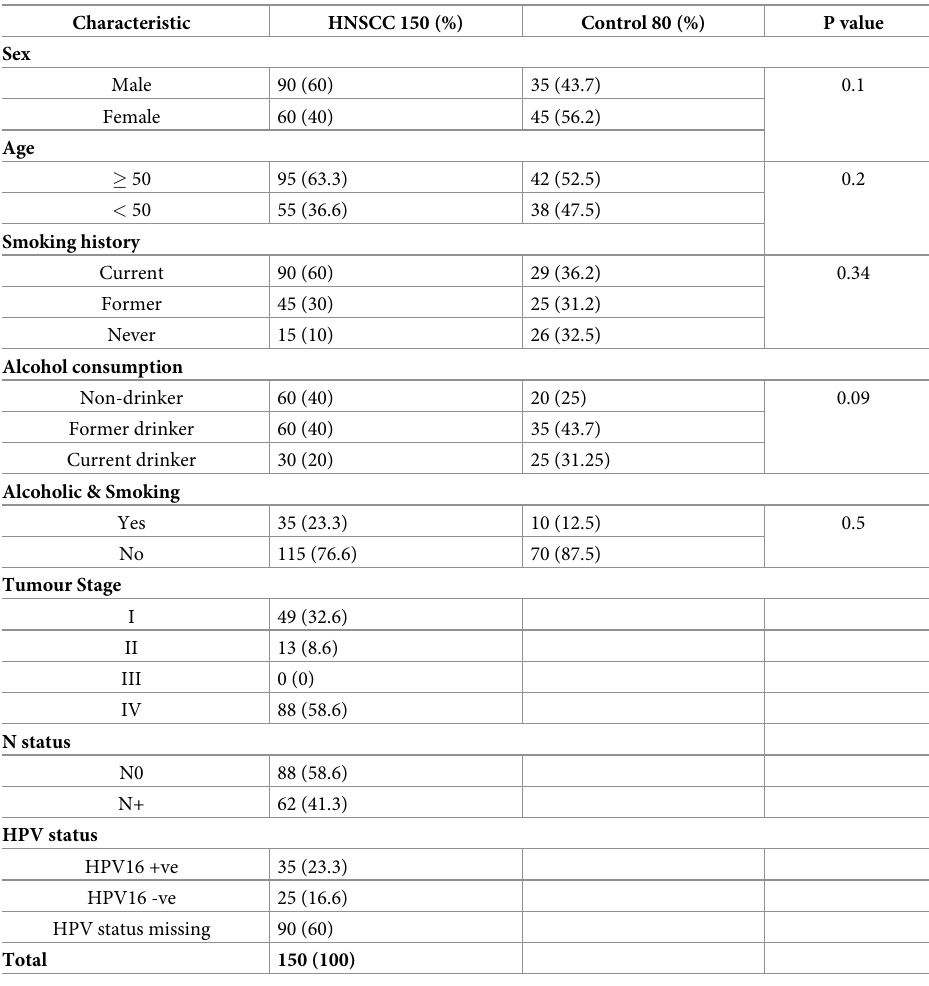
Table 1. Demographic and clinical characteristics of HNSCC